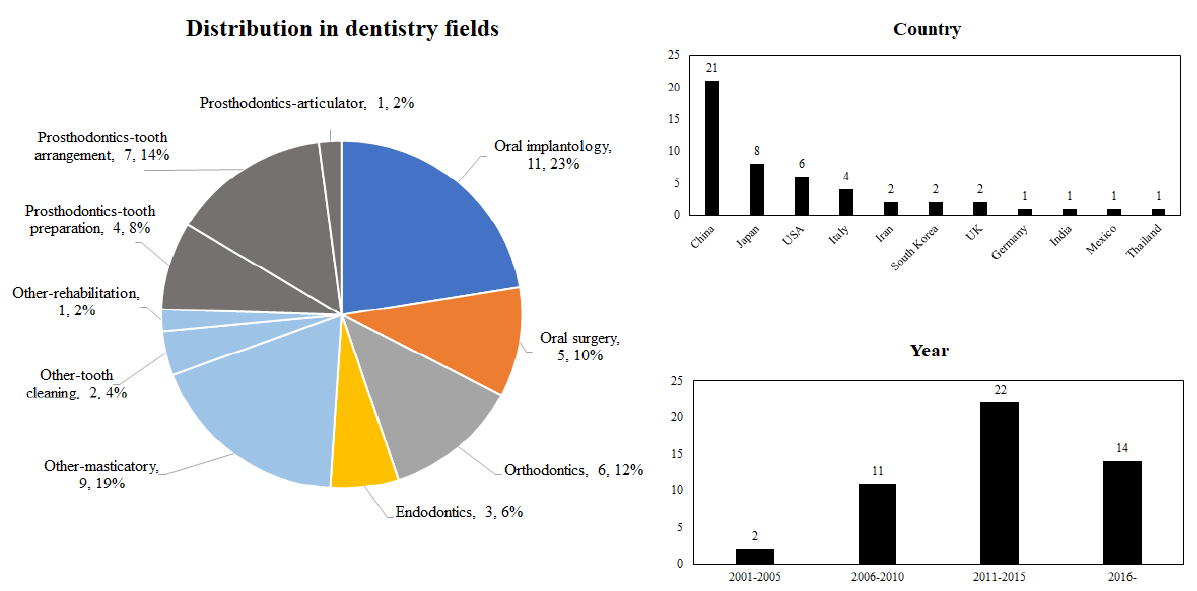
Figure 2. ( a ) Dentistry field distribution of selected articles; ( b ) Country distribution of selected articles; ( c ) Publication time distribution of selected articles .